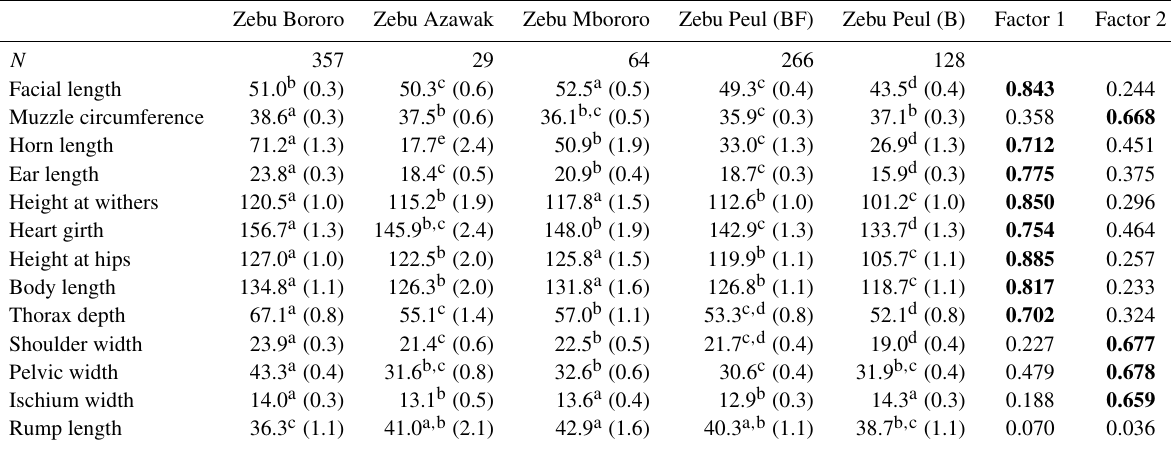
Table 1. Least squares means (in cm) and their standard errors (in brackets) for 13 body measurements assessed in cows belonging to five West African zebu cattle breeds. Results and sample size ( N ) are given per breed. Eigenvectors computed for two factors identified via principal component analysis (eigenvalues > 1) are also given. Eigenvectors higher than | 0.492 | are in bold. Factor 1 explains 56.43% of the total variability. Factor 2 explains 9.32% of the total variability. Different superscripts denote significantly different trait raw means at p < 0.05. “(BF)” and “(B)” mean Burkina Faso and Benin, respectively.